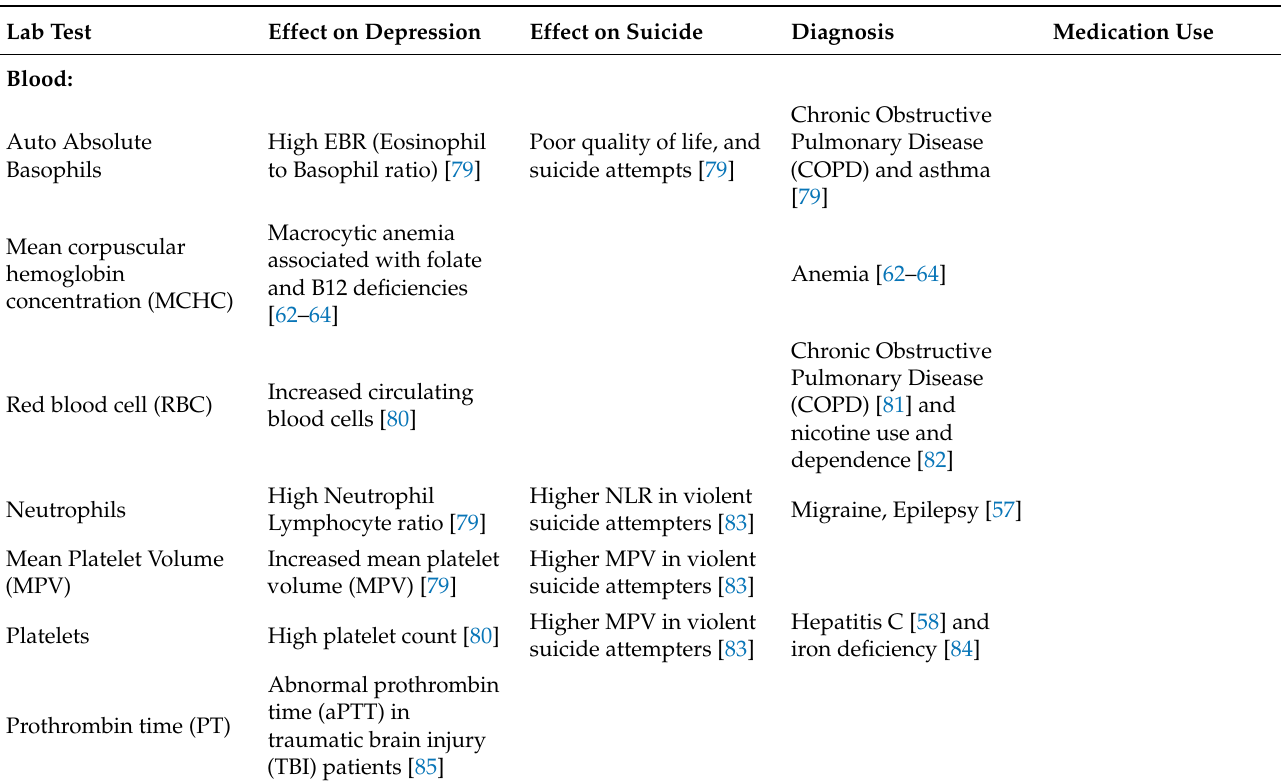
Table 5. Top biomarkers for prediction of suicide-related events (SREs) in PTSD patients along with the effect on depression, suicide, related diagnosis, and medication